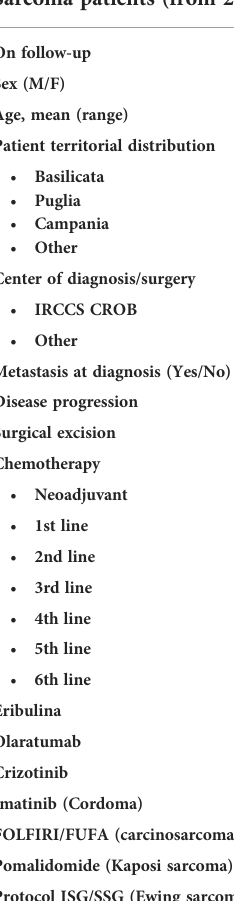
TABLE 1 General characteristics and management information of the enrolled sarcoma patients. Sarcoma patients (from 2009 to